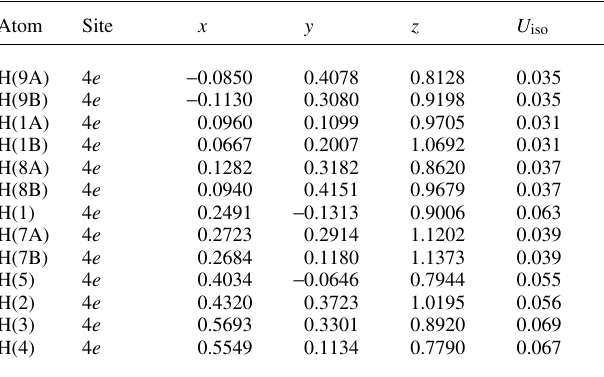
Table 2. Atomic coordinates and displacement parameters (in Å 2 )